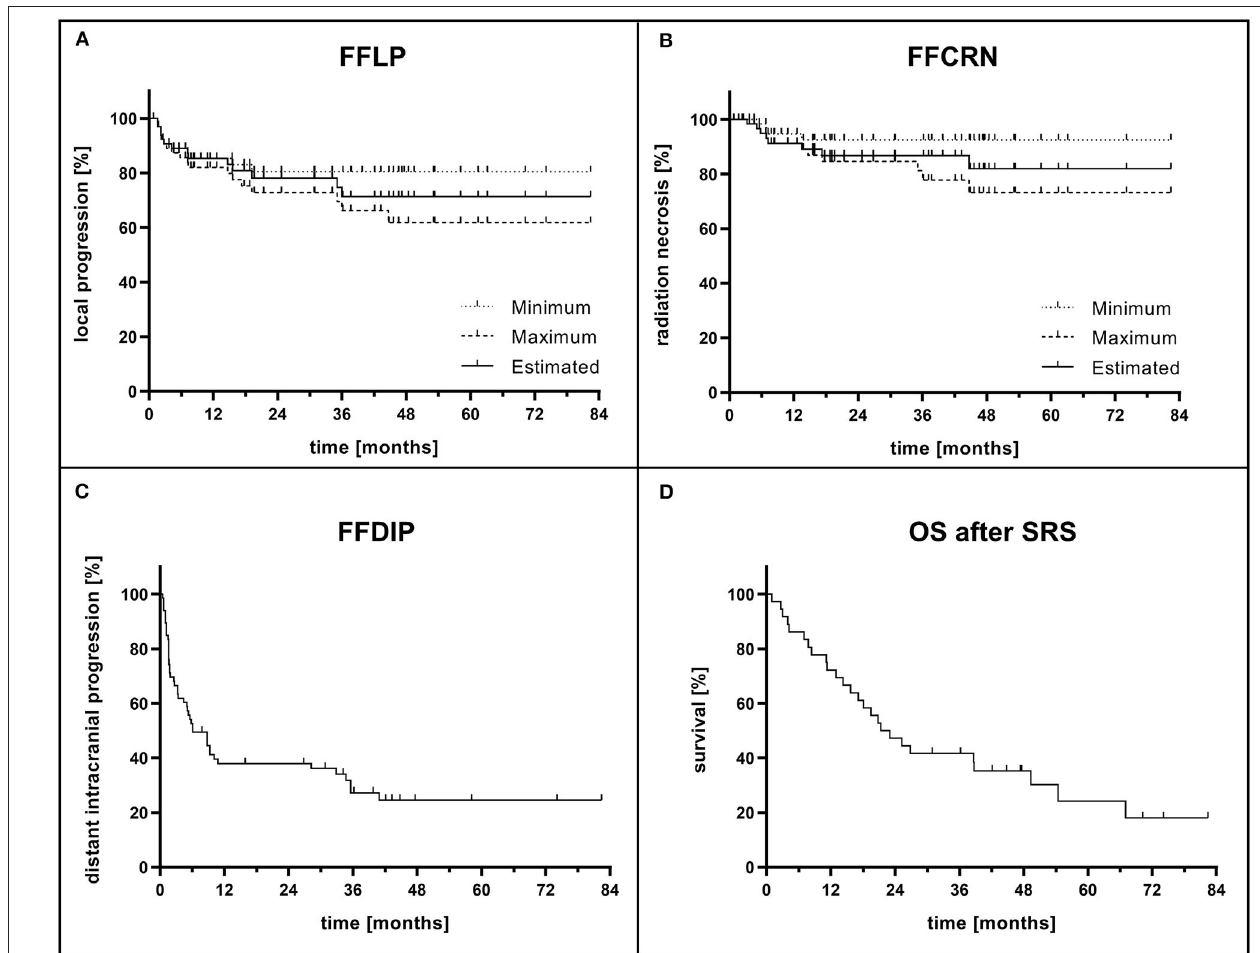
FIGURE 2 | (A) Freedom from local progression (FFLP) and (B) freedom from CNS radiation necrosis (FFCRN) after single-fraction stereotactic radiosurgery (SRS) and concurrent immunotherapy calculated for each brain metastasis (BM, n = 66). The actual rates are expected to be in the range between minimum and maximum rate. Based on interdisciplinary decision, the estimated result is shown. (C) Freedom from distant intracranial progression (FFDIP) after SRS and concurrent immunotherapy calculated for each BM. (D) Overall survival (OS) after SRS and concurrent immunotherapy calculated for each patient ( n =